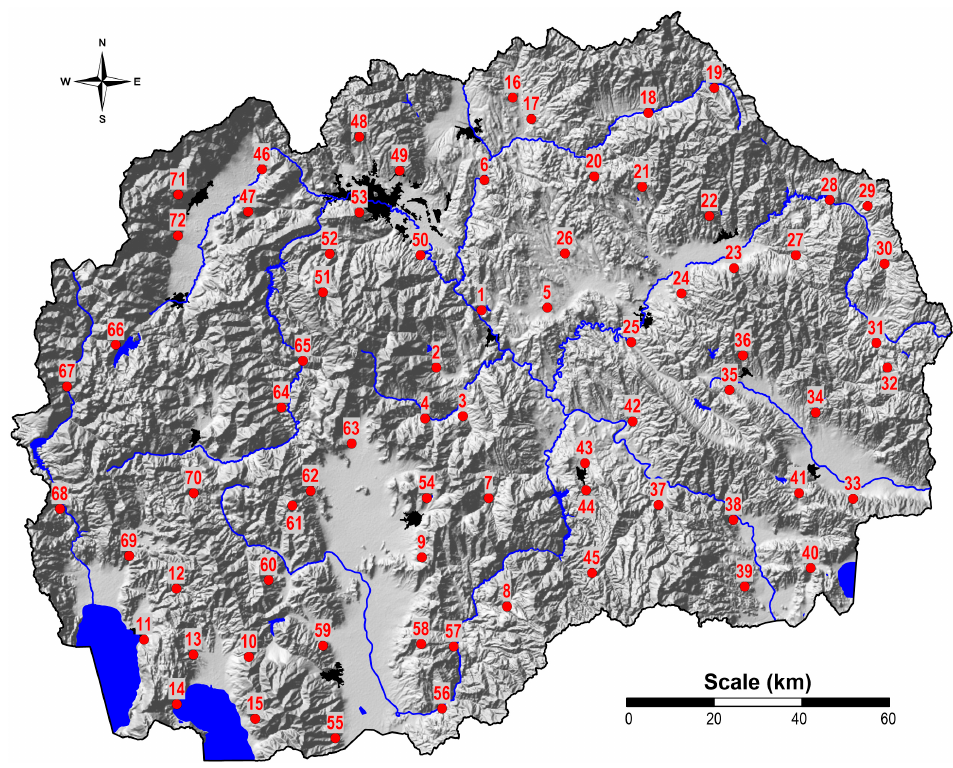
Figure 3. Location of sampling points.